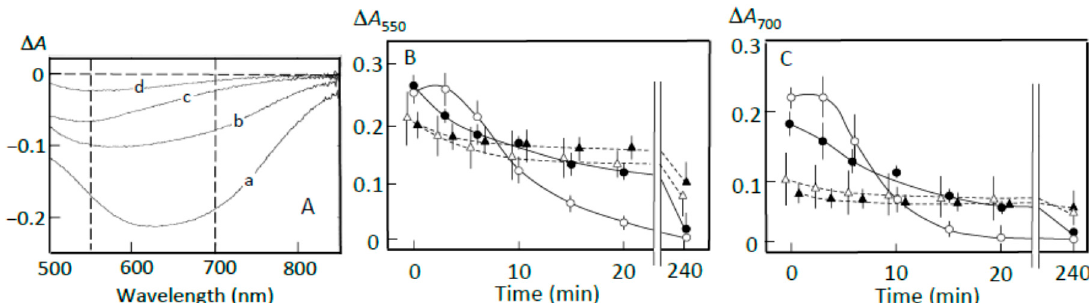
Figure 6. Pancreatin-induced starch digestion of the supernatant. ( A ) ∆ A spectra of 10 min minus 0 min of incubation. ( a ) 0 μ L, ( b ) 3 μ L, ( c ) 6 μ L, ( d ) 10 μ L of adzuki extract. ( B , C ) Time courses of starch digestion estimated at 550 and 700 nm, respectively. ( ○ ) 0 μ L, ( ● ) 3 μ L, ( ∆ ) 6 μ L, ( ▲ ) 10 μ L of the adzuki extract.